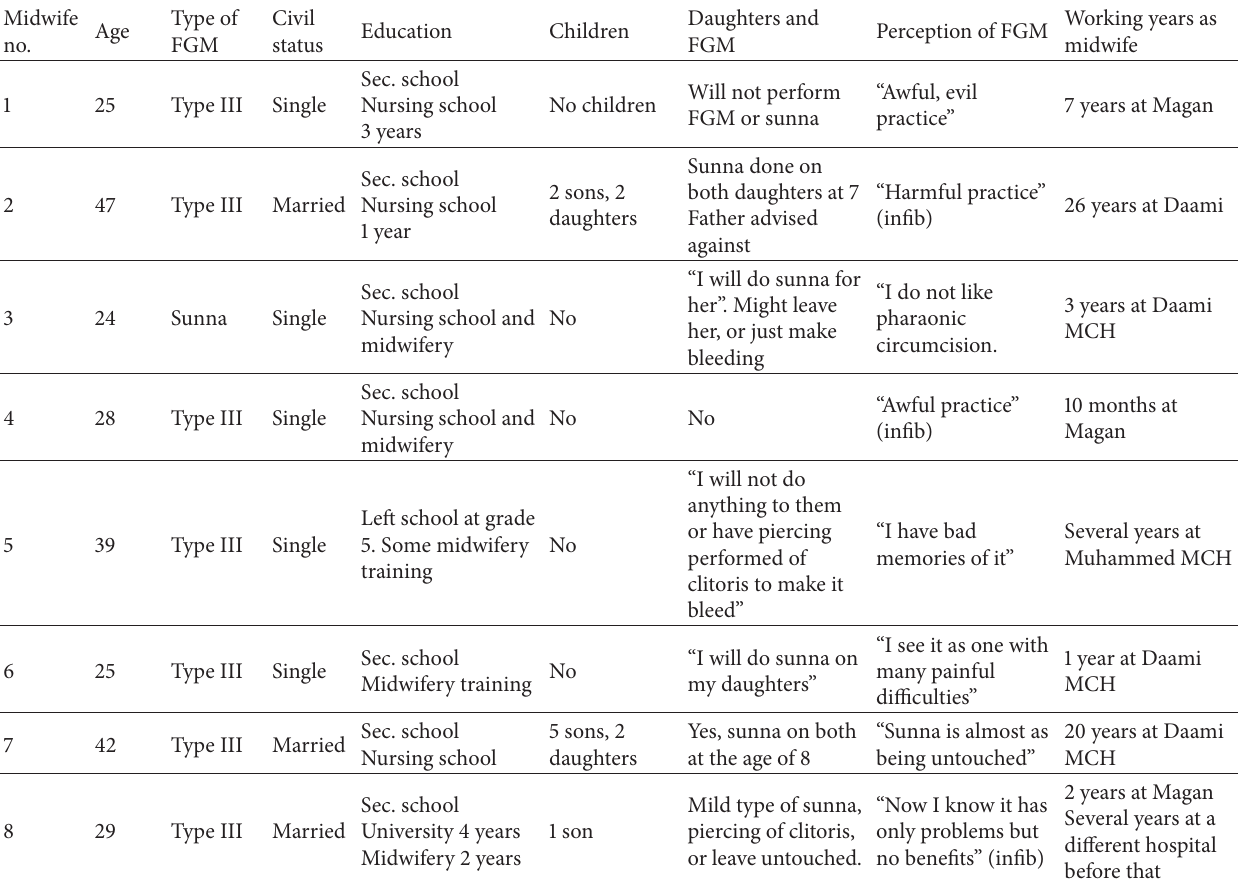
Table 1: Background characteristics and views on the eight midwives participating in the study.